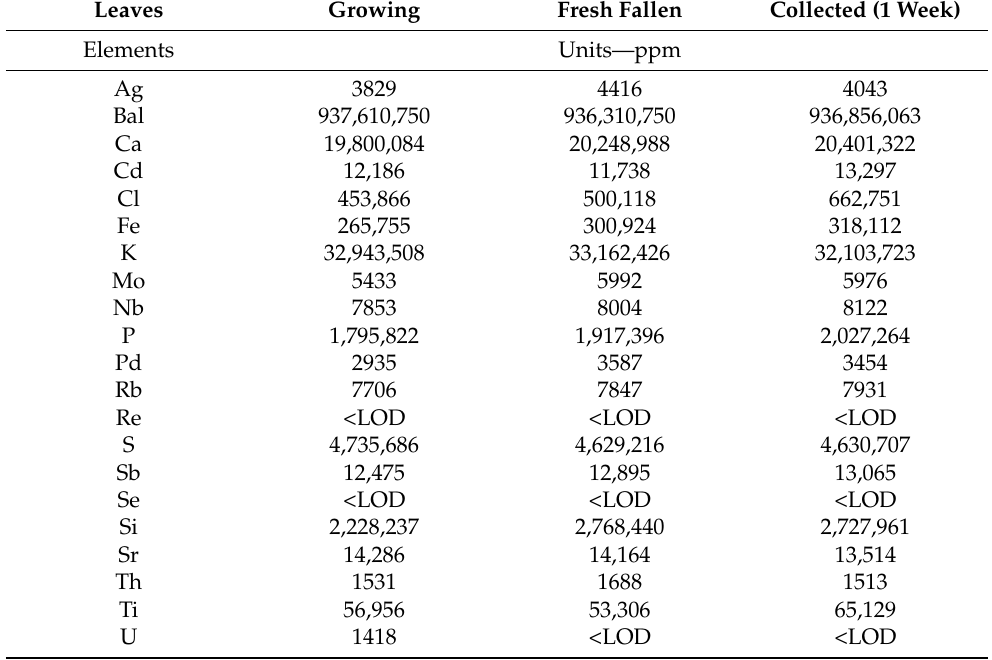
Table 2. Elemental composition of the investigated